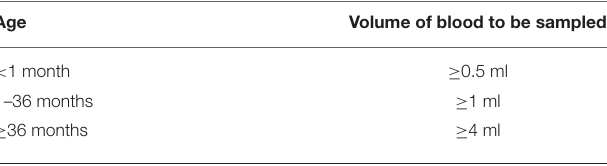
TABLE 5 | Recommended blood volumes for blood culture in children based on age (166, 170, 171). Age Volume of blood to be sampled